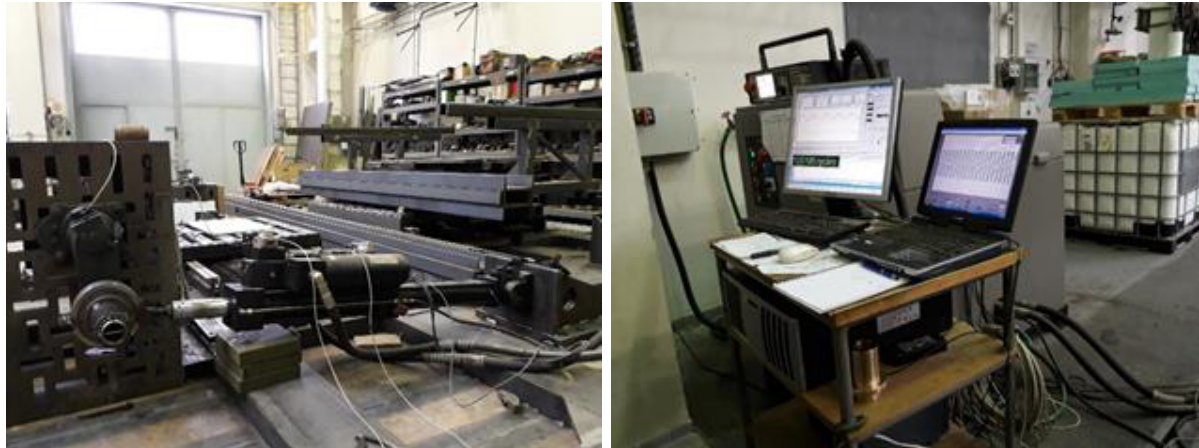
Figure 4. Experimental test rig.